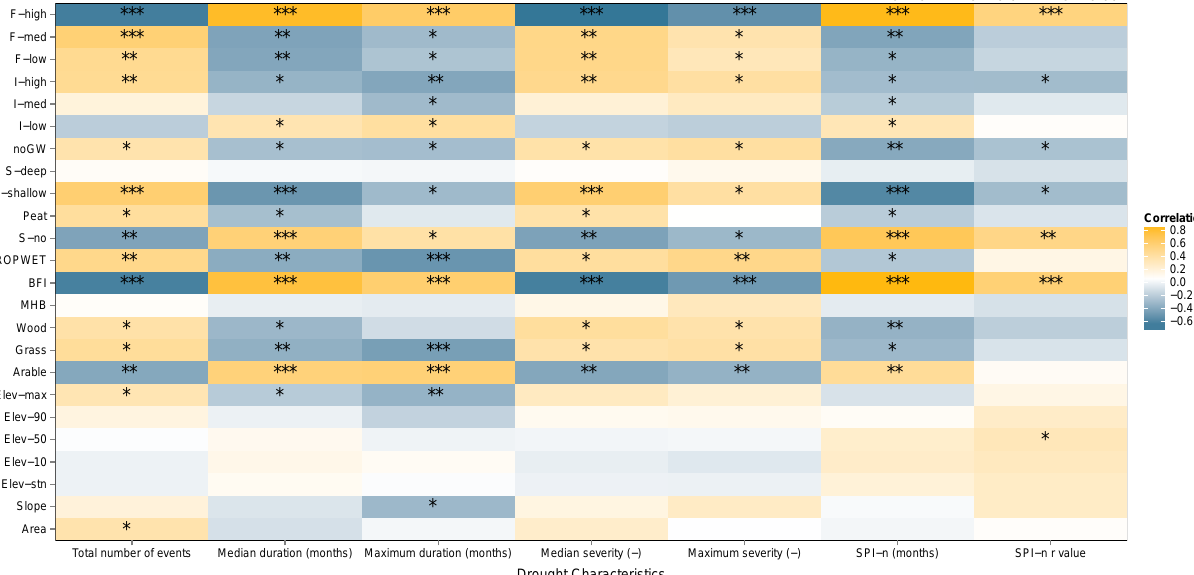
highly permeable or are largely influenced by